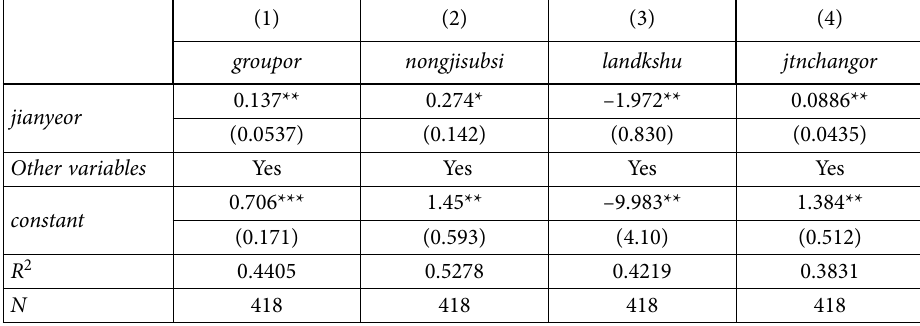
Table 4. Analysis of influential mechanism on agricultural labor